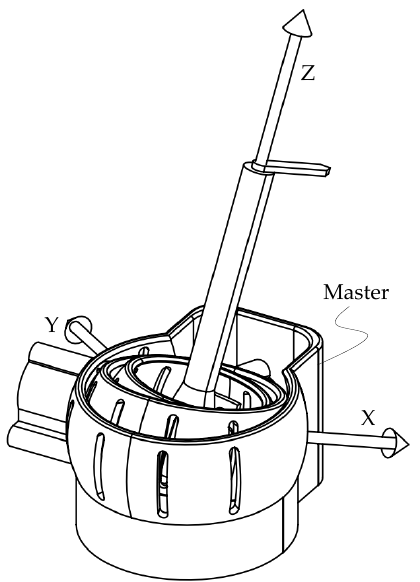
Figure 1. The master mechanism.